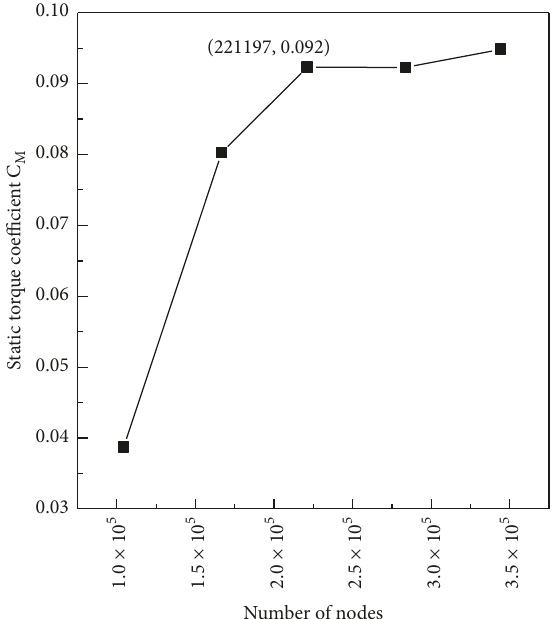
Figure 4: Mesh independent